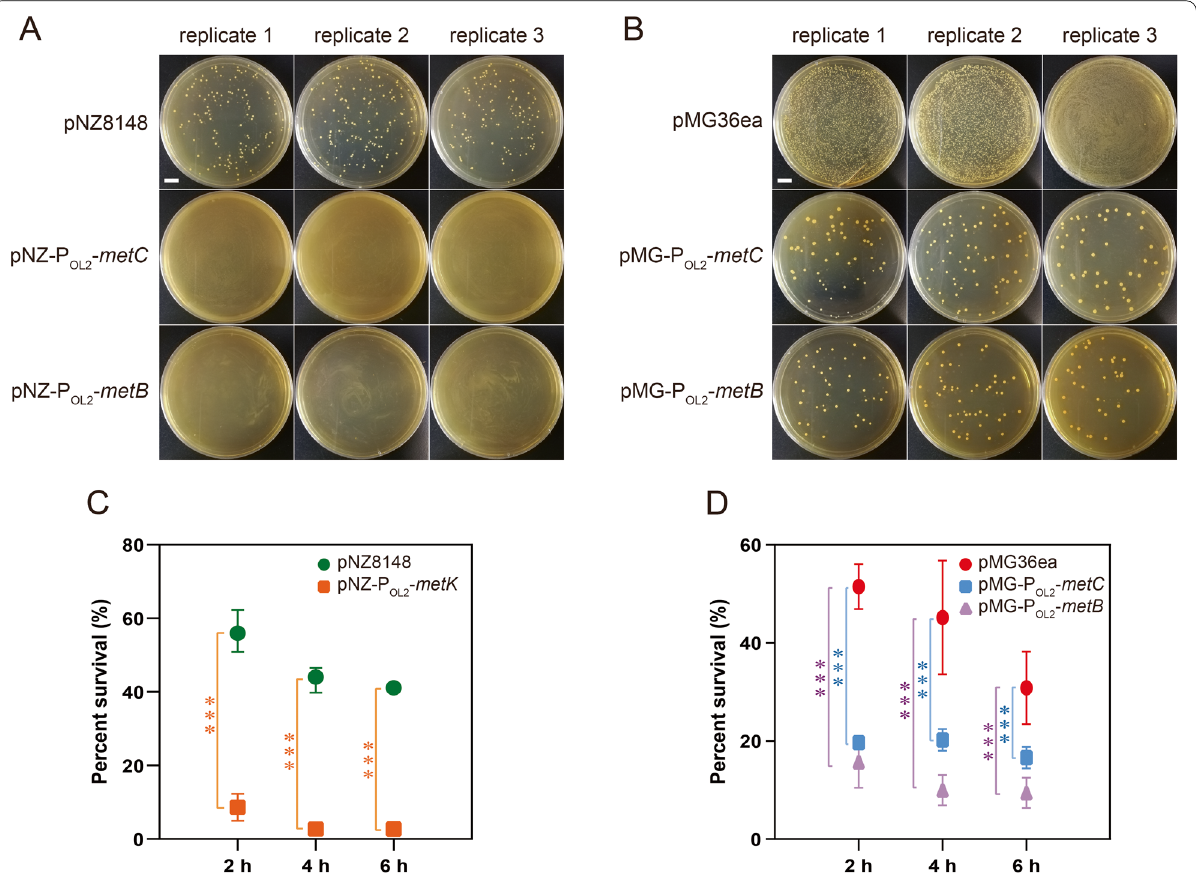
Fig. 4 Plate screening after the L. plantarum XJ25 competent cells electrotransformed with the pNZ8148 plasmid derivatives, which shared a high-copy-number replicon in their backbones ( A ). Scale bar represents 1 cm. Plate screening after the L. plantarum XJ25 competent cells electrotransformed with the pMG36ea plasmid derivatives, which harbored a medium-copy-number replicon in their backbones ( B ). Scale bar represents 1 cm. The survival rates of L. plantarum XJ25 cells overexpressing metK ( C ), metC and metB ( D ) under acid stress with 2 mM methionine. *** p < 0.001 (Student’s t